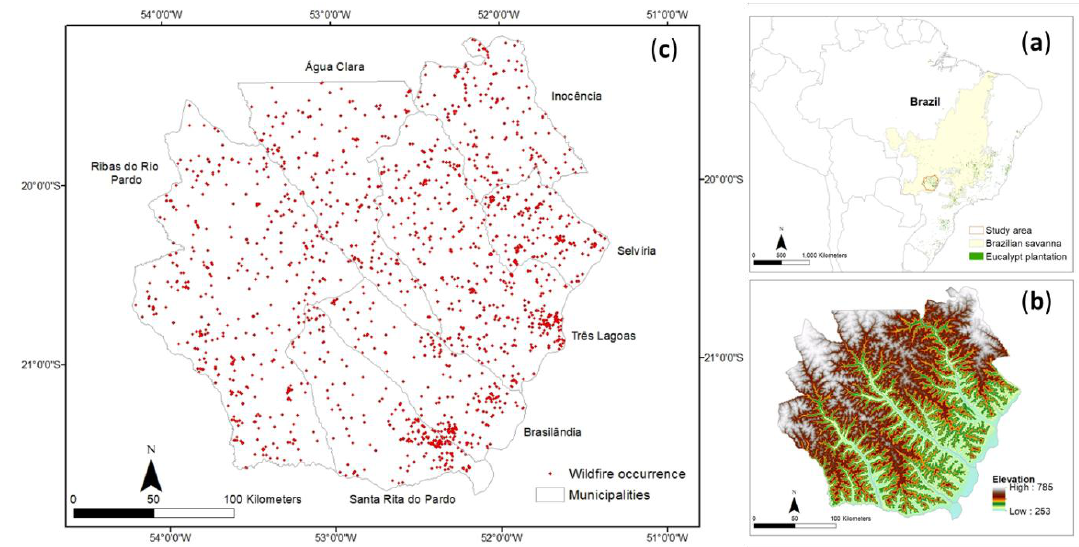
Figure 1. ( a ) Study area location, Brazilian savanna biome, and eucalypt plantation distribution in Brazil (2016). ( b ) Elevation gradient of the study area. ( c ) Spatial distribution of wildfires occurrence (2010–2016; Brazilian Institute of Space Research [INPE]) over municipalities limits.